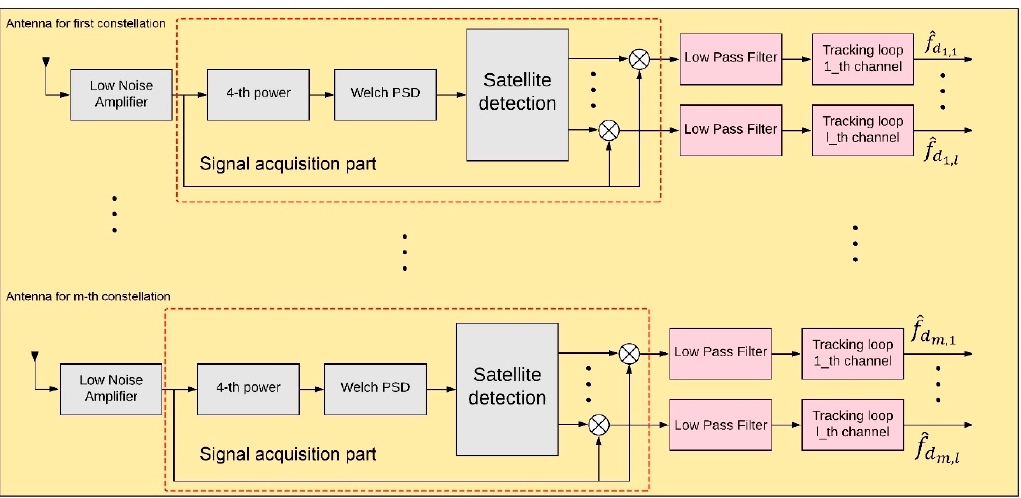
Figure 4. Architecture of proposed multi-constellation LEO satellite receiver.